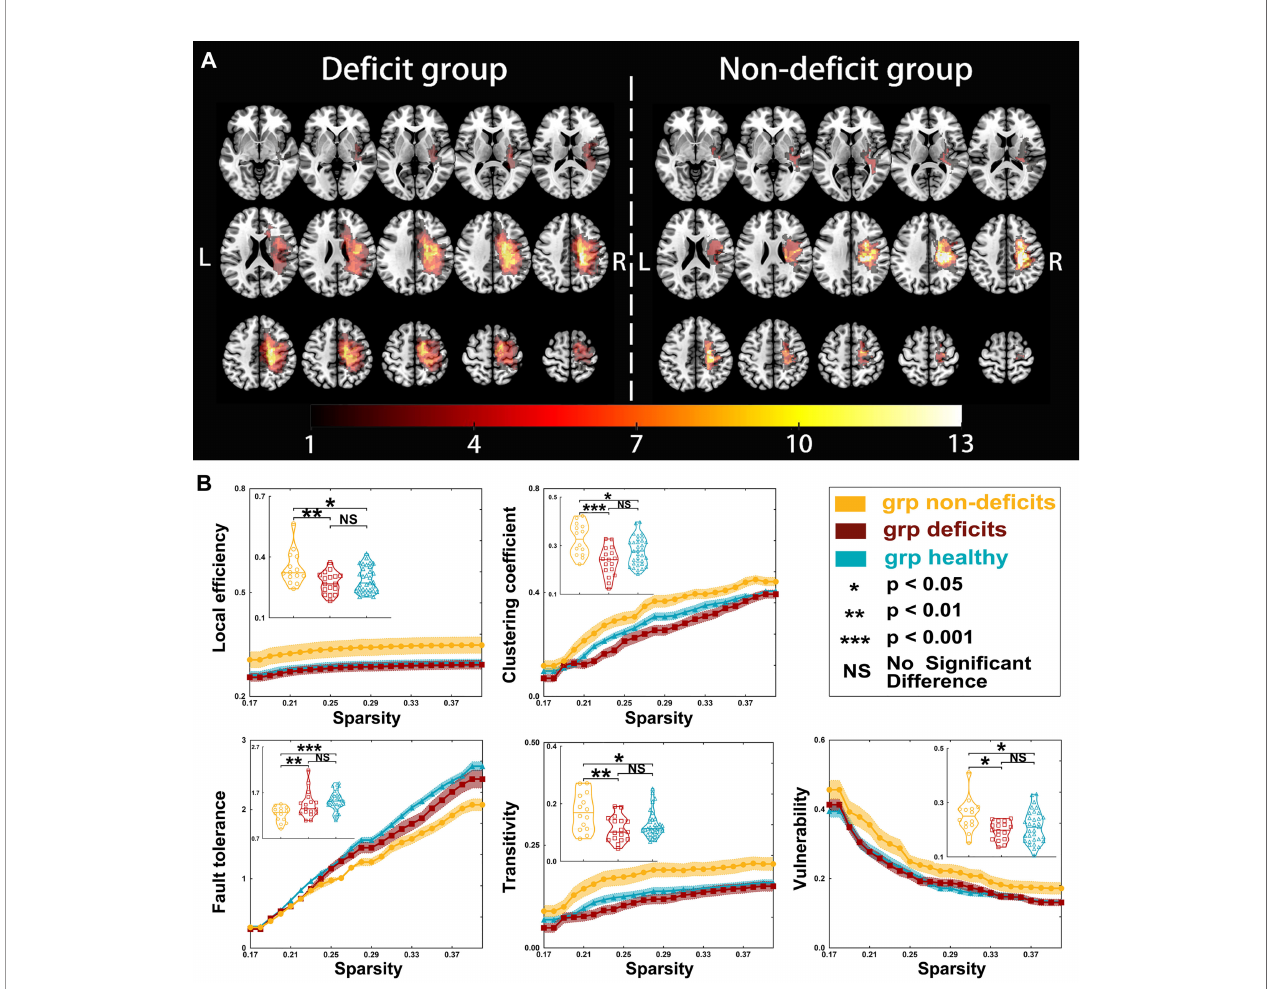
FIGURE 2 | Tumor location and global properties of patients with right hemispheric gliomas. (A) Overlapping results of gliomas in the right hemisphere. The value of the color bar represents the number of patients with tumors located in a same region. (B) Differences in global topological properties of the sensorimotor network in the contralesional hemisphere among the three